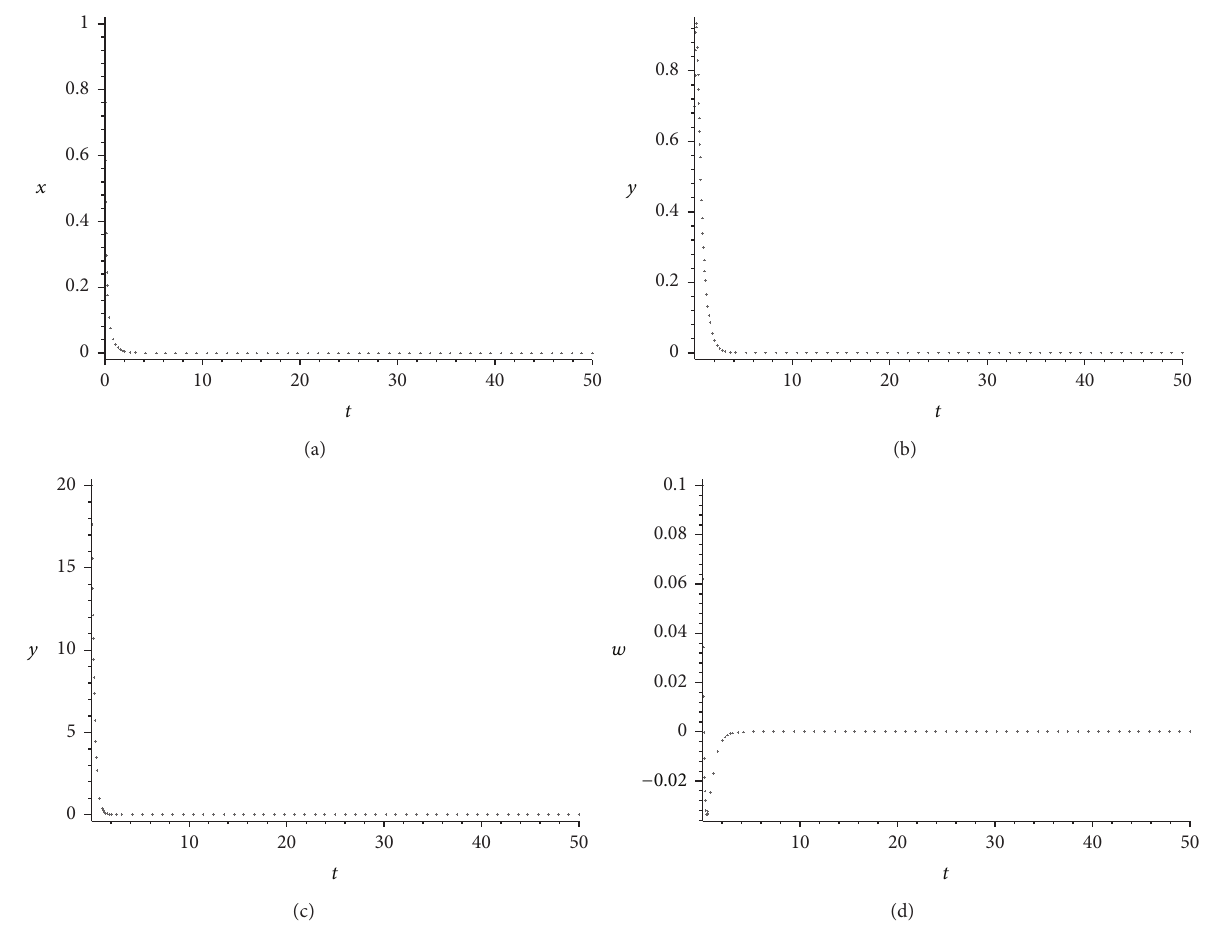
Figure 3: The states of system (9): (a) 𝑥 - 𝑡 , (b) 𝑦 - 𝑡 , (c) 𝑧 - 𝑡 , (d) 𝑤 - 𝑡